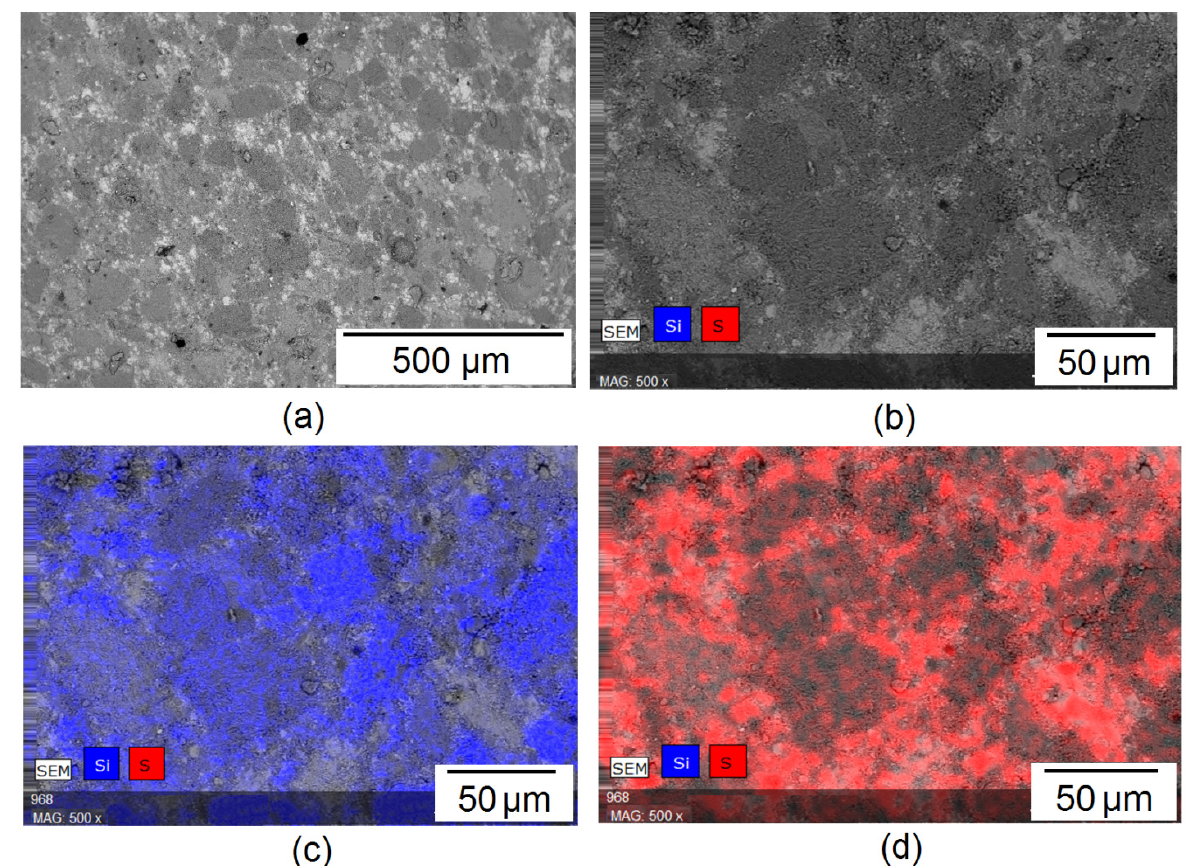
Figure 6. Micrographs of a sulfur/marshalite composite (35%/65%).( a ) microstructure, ( b ) microstructure c approximate, ( c ) distribution of silicon, ( d ) distribution of sulfur. (2-column fitting image).